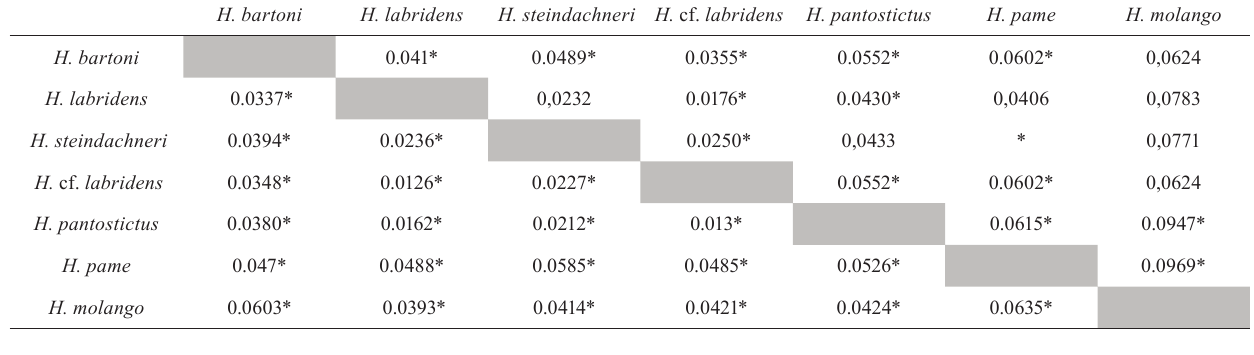
Table 2. Procrustes distances among the seven taxa of the the Herichthys bartoni species group included in this study. Above the diagonal the results for the 15 landmarks of the head, below the diagonal the results for the 25 landmarks of the body. * denotes significant p values (p< 0.05) after 10,000 iterations.